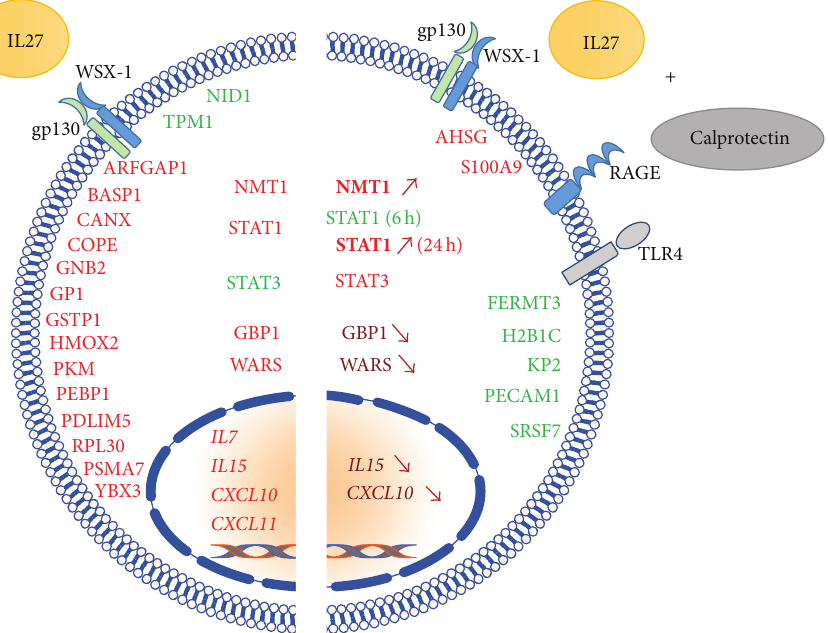
Figure6:QualitativerepresentationofthecalprotectinmodulatoryeffectsonIL27-mediatedproteinandgeneexpressioninHUVECs.Colour code: red: upregulation, bold red (arrow up): increased upregulation compared to IL27 stimulation only, dark red (arrow down): decreased upregulation compared to IL27 stimulation only, and green: downregulation. IL27 receptor: gp130/WSX-1 and calprotectin receptors: RAGE (advanced glucated end product receptor) and TLR4 (Toll-like receptor 4).